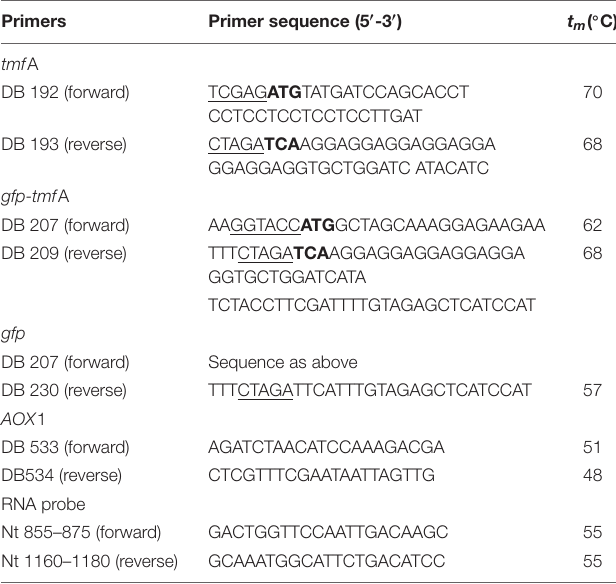
TABLE 1 | Primers used for the genetic engineering of P. pastoris cells. Primers Primer sequence (5 (cid:48) -3 (cid:48)